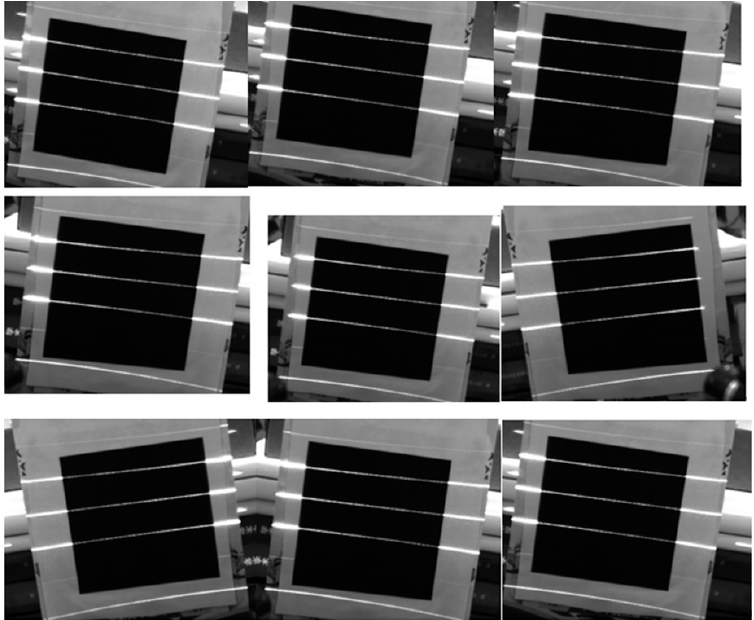
Figure 13. The image of light stripe centerline extraction with black plate.